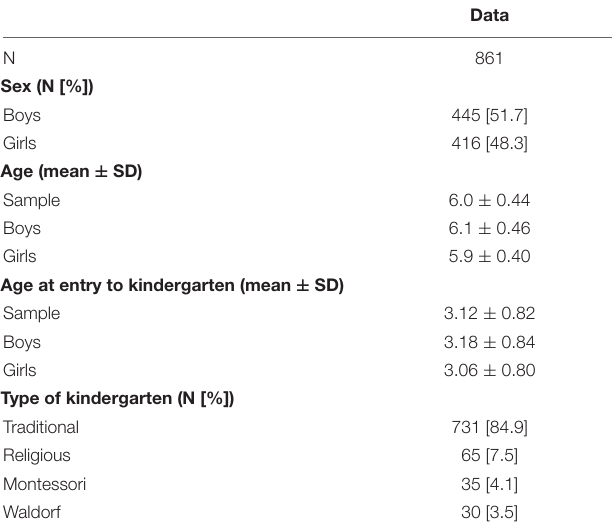
TABLE 1 | Sample characteristics.